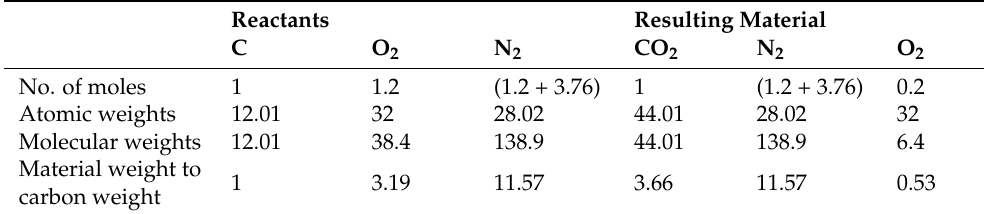
Table 3. The chemical properties of interacting carbon with 20% excess air.